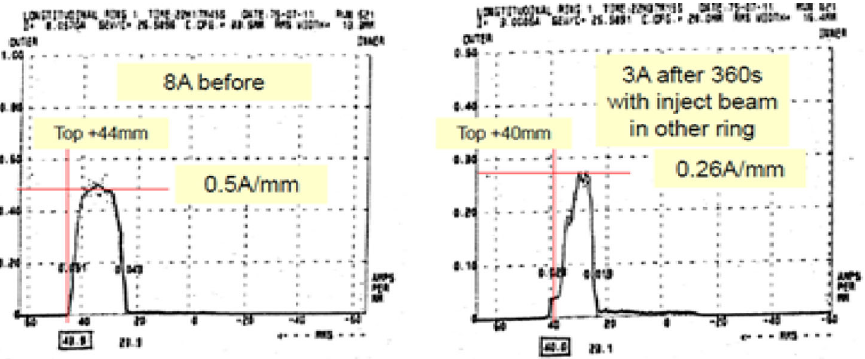
FIG. 17. Density profiles before and after